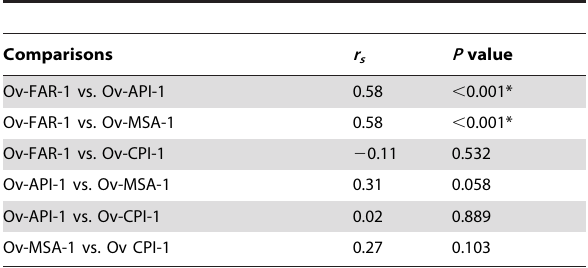
Table 2. Correlation of antibody titers between the four Ov antigens with the 38 Ov -infected sera.